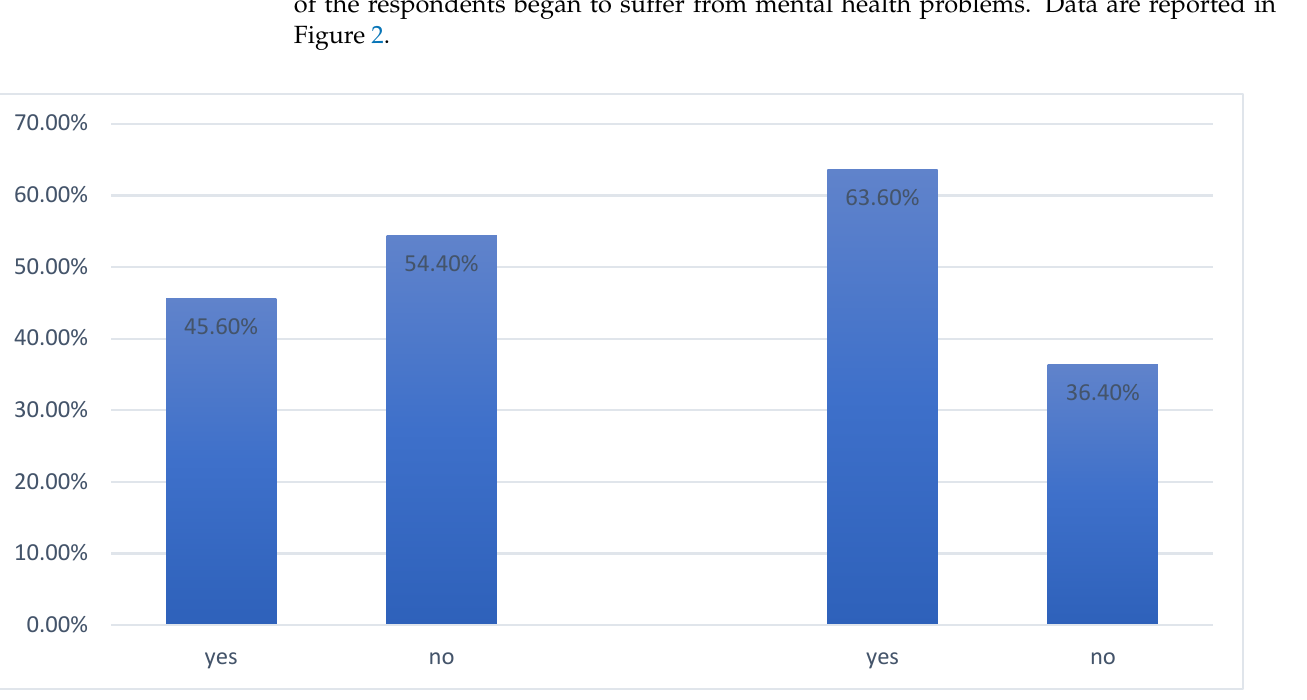
Figure 2. Perceived psychological distress before and during the COVID-19